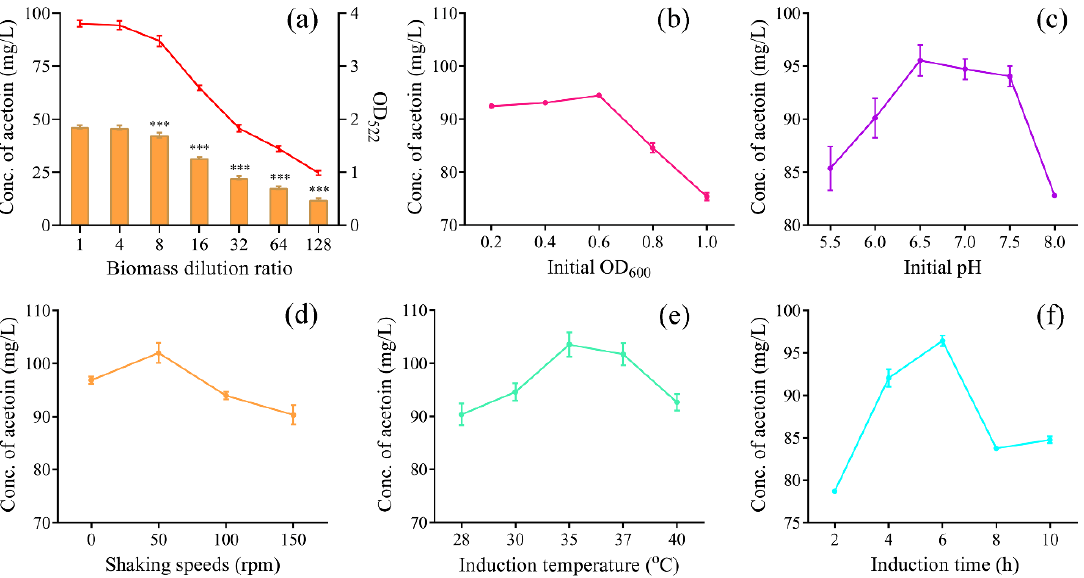
Figure 5. The effect of biomass dilution ( a ) and induction conditions ( b ‒ f ) on acetoin production. *** denotes a significant difference at p < 0.001. *** denotes a significant difference at p < 0.001.